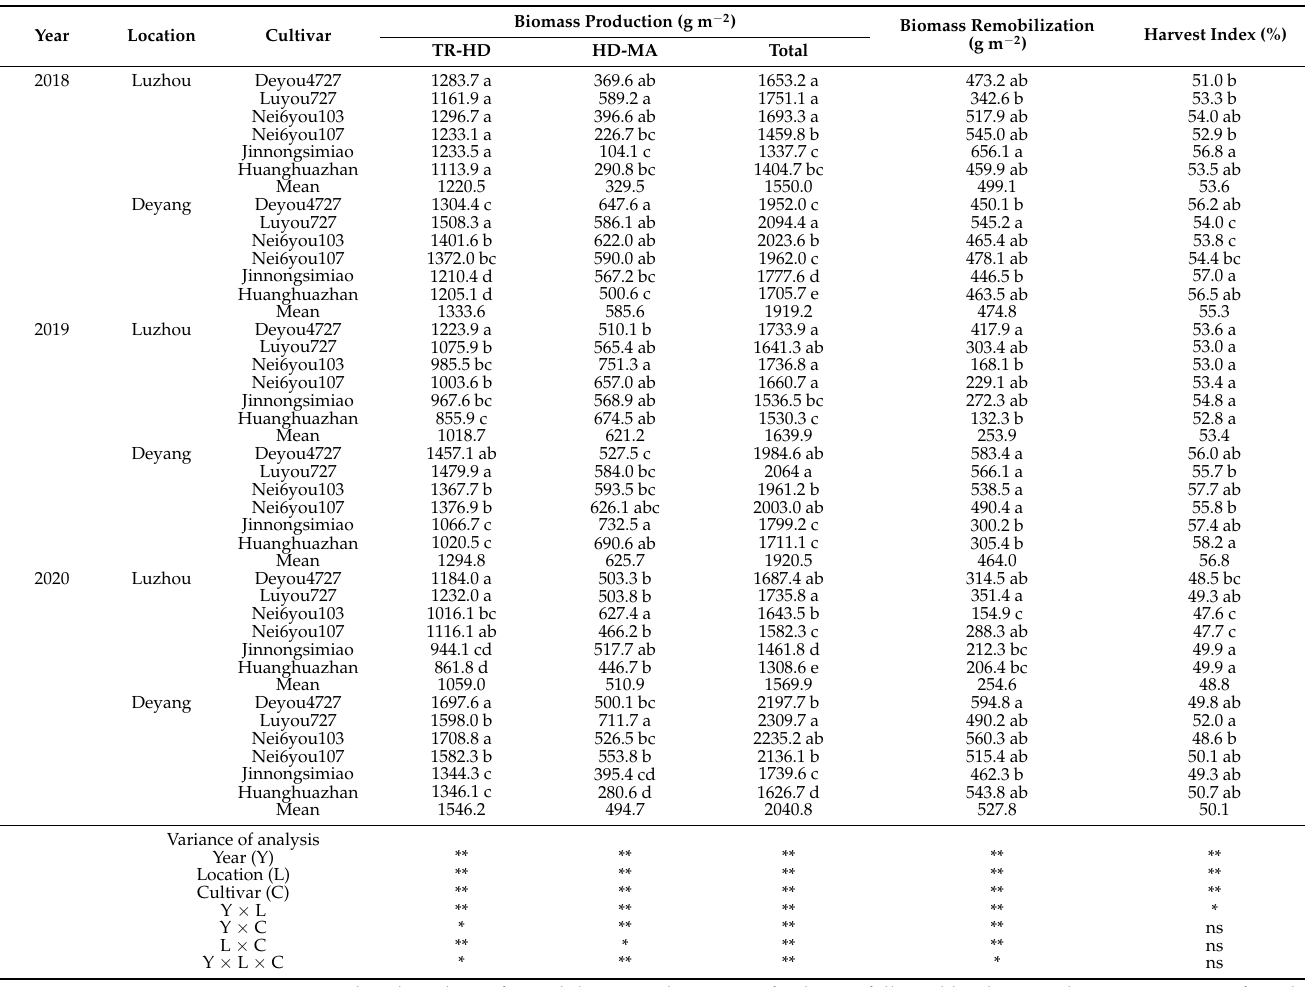
Table 5. Biomass production, biomass remobilization, and harvest index of six rice cultivars grown under two different ecological conditions in a field experiment from 2018 to 2020.